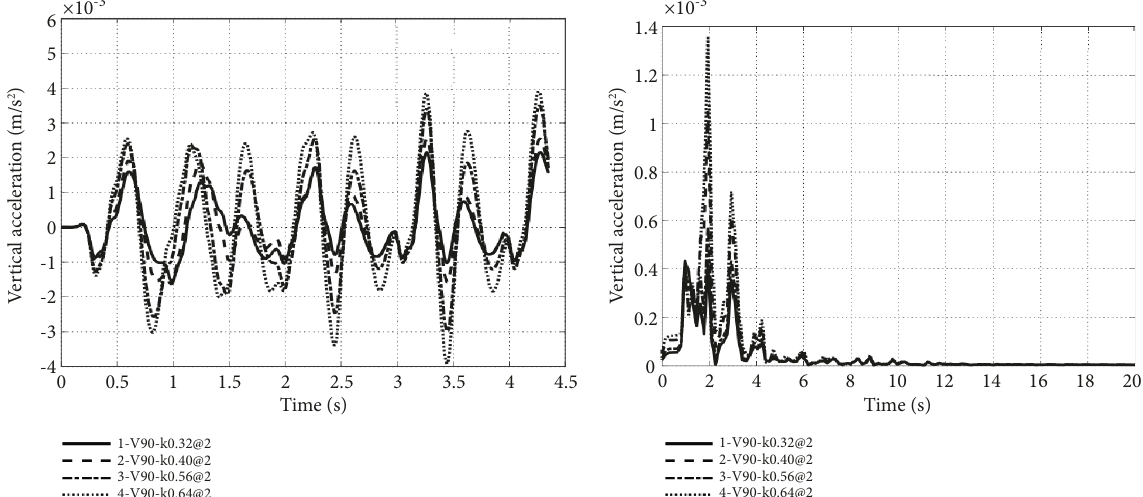
Figure 14: Vertical acceleration response of vibration pickup point under change of spring stiffness.